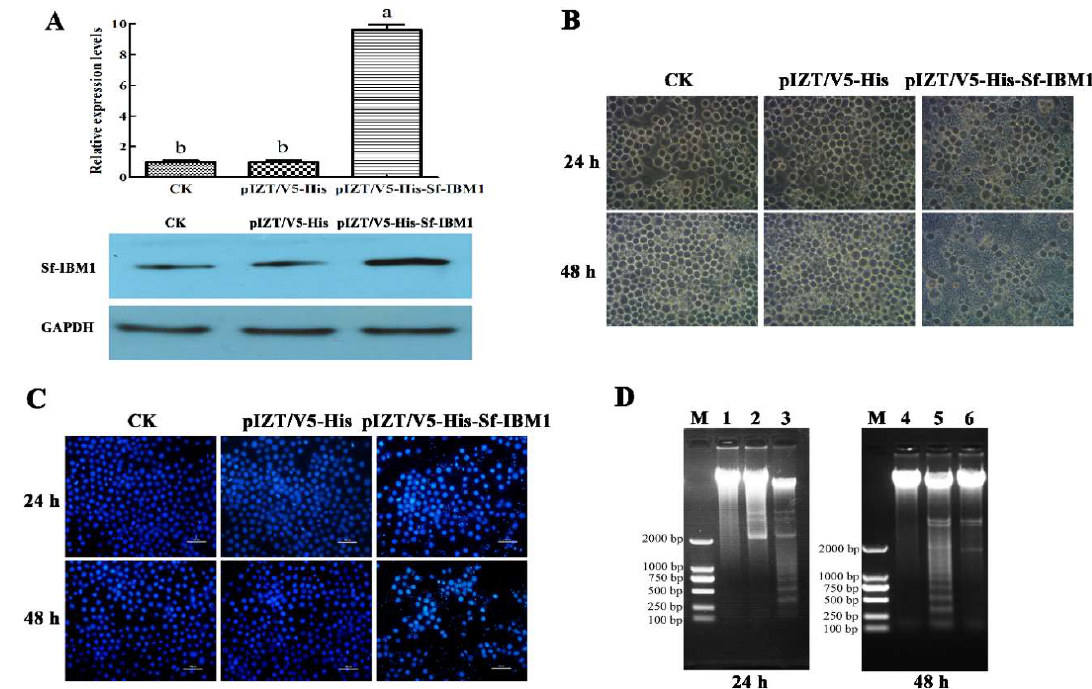
Figure 4. Overexpression of Sf-IBM1 induced apoptosis in Sf9 cells. ( A ) Transfection with pIZT/V5-